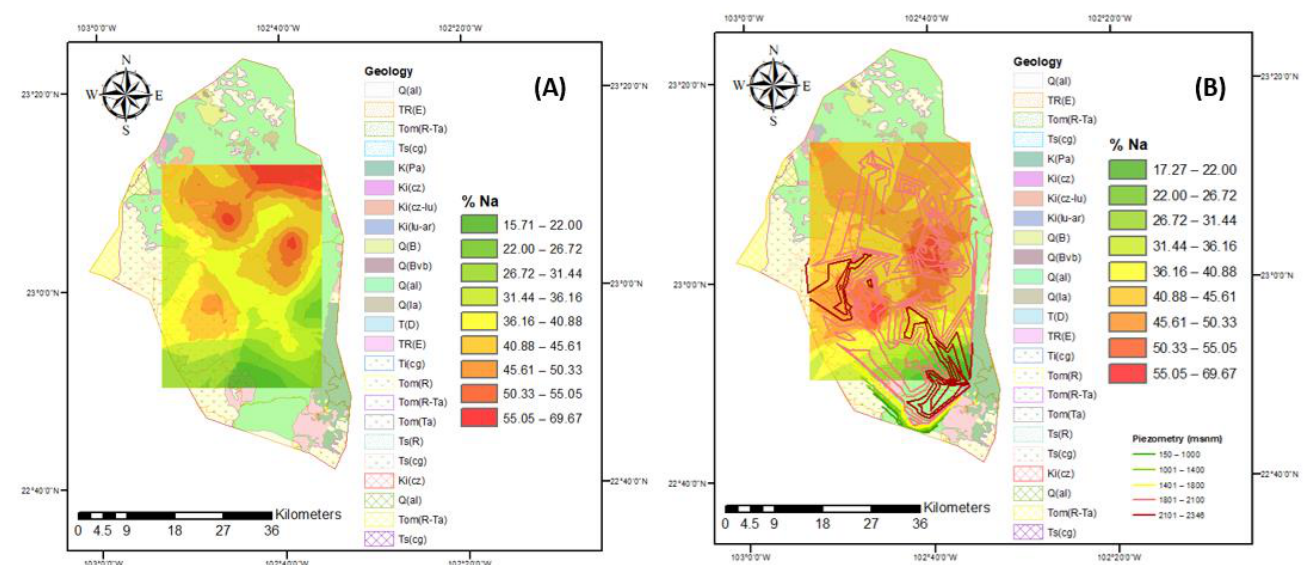
Figure 9. %Na present in the Calera aquifer around the sampling area for the years ( A ) 2005 and ( B ) 2015.